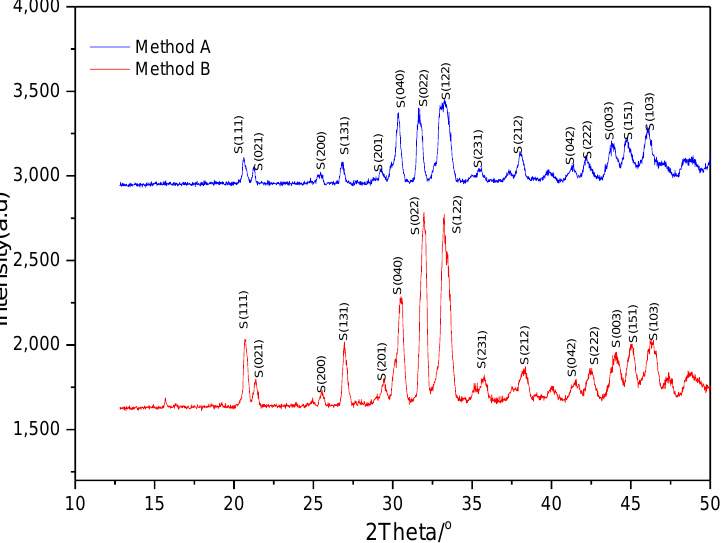
Figure 8. XRD patterns for the solid obtained by precipitation of struvite from supersaturated solutions prepared according to methods A and B. S: